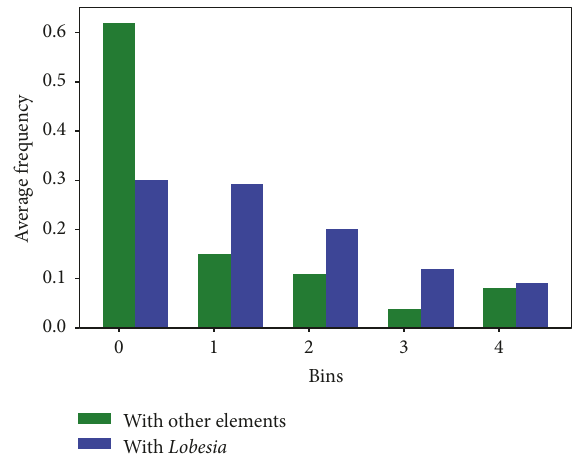
Figure 11: Gradient modulus descriptor Lobesia versus that without Lobesia .